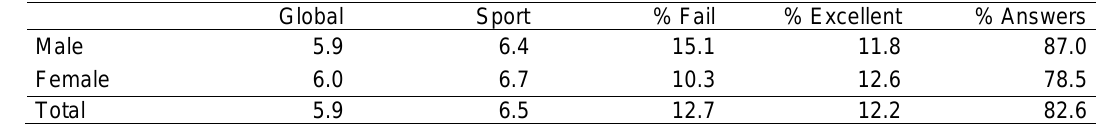
Table 2. Average assessment of municipal management by gender (2017). Global Sport